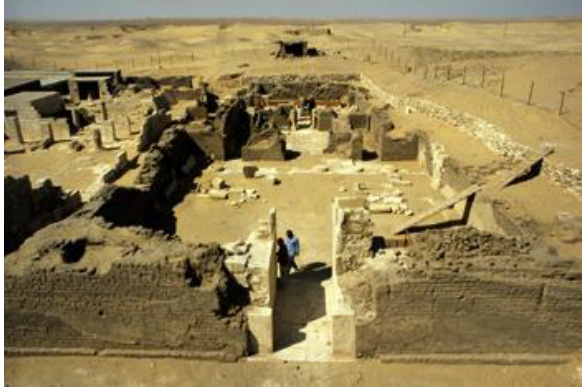
Figure 3. The Tomb of Maya when it was unearthed (from www.saqqara.nl/tombs/tomb-of-maya-found-in-1986/)